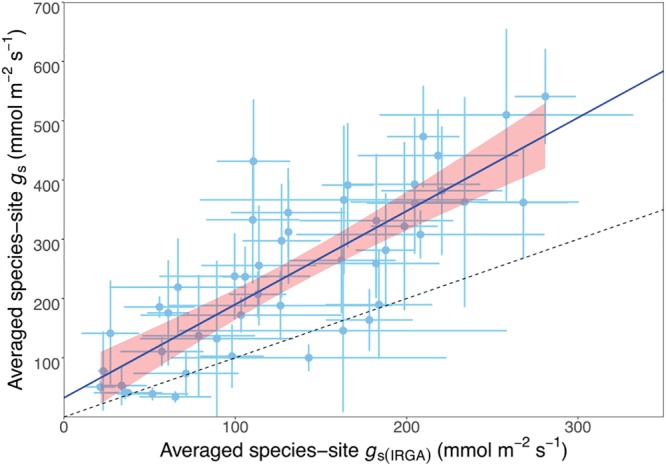
Scatterplot of matching porometer- and infrared gas analysis- (IRGA-) measured species-site (i.e., from the same species at the same site) stomatal conductance (gs) showing a linear relationship, where the equation average species-site gs = 1.42 · average species-site gs(IRGA) + 30. r2 = 0.81, n = 48, P < 0.01. The dashed line is the 1:1 relationship.